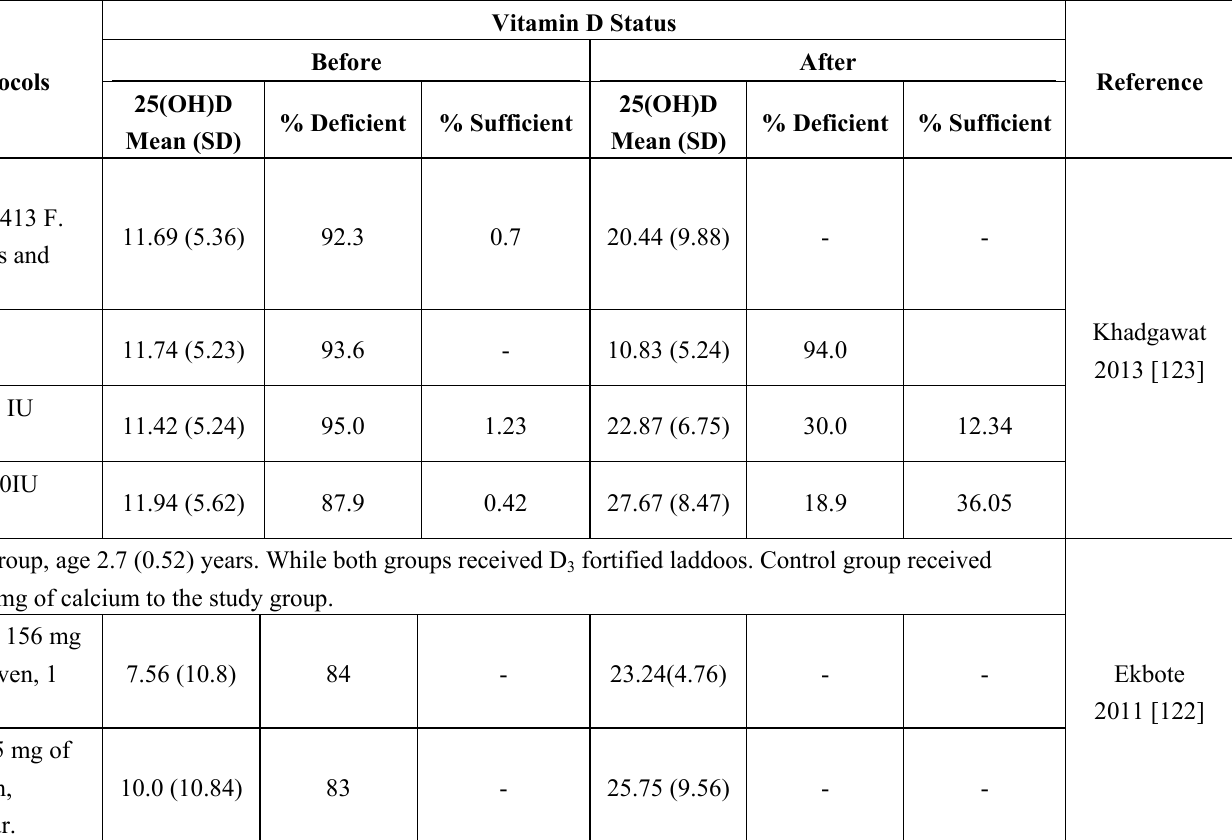
Locale Study Subjects and Fortification